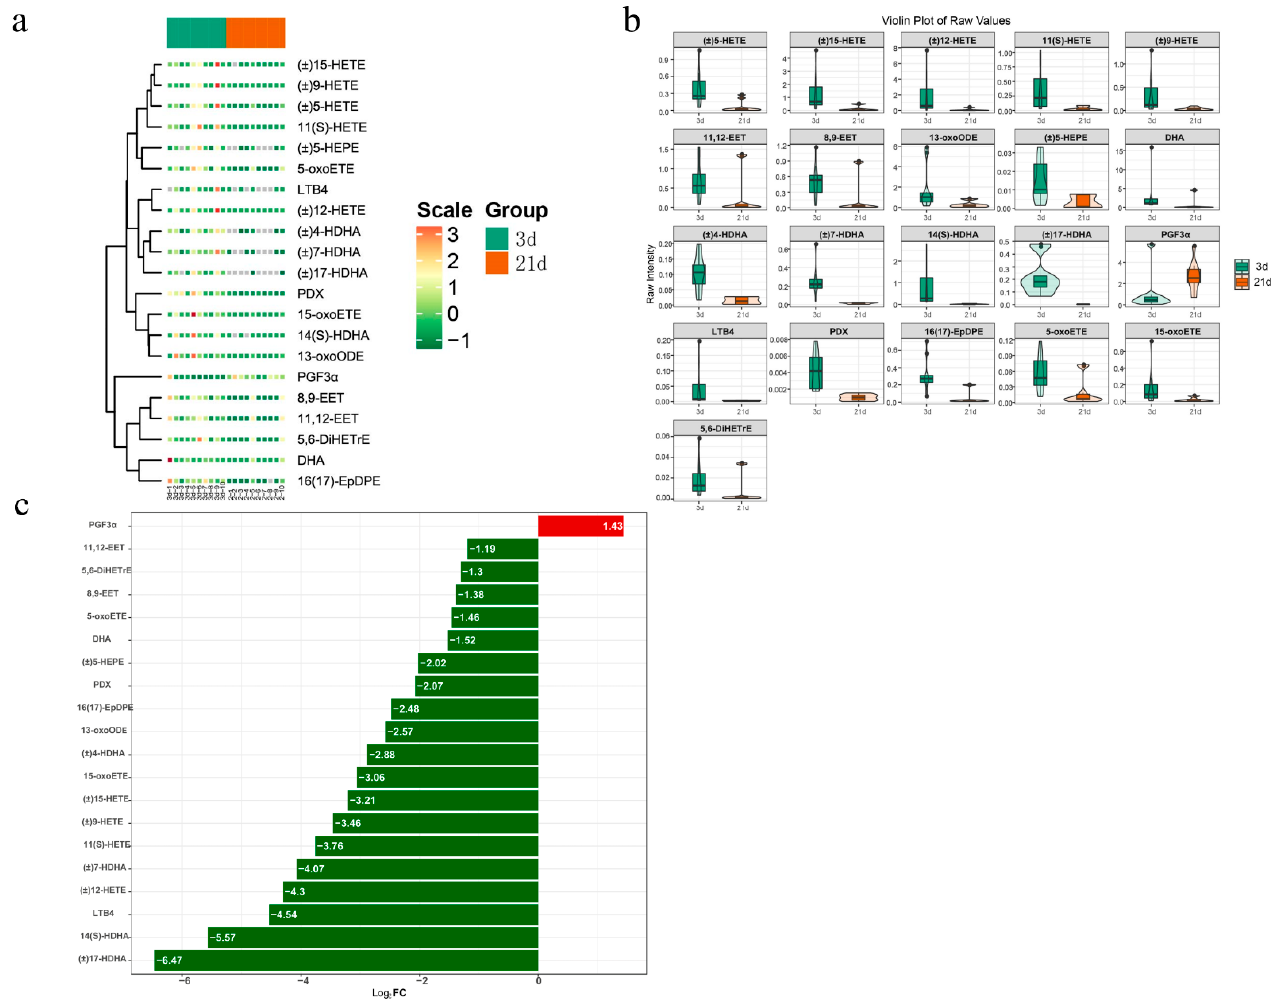
Figure 3. Differential oxylipins were analyzed in feces between 3d and 21d postnatally (n=10). (a) Heatmap analysis of detected 21oxylipins in this study. (b) Violin plot analysis of 21 differential 21oxylipins in this study. The x axis indicates the name of the groups, and the y axis indicates the expression quantity. (c) The bar plot of top 20 up-regulated and down-regulated oxylipins.